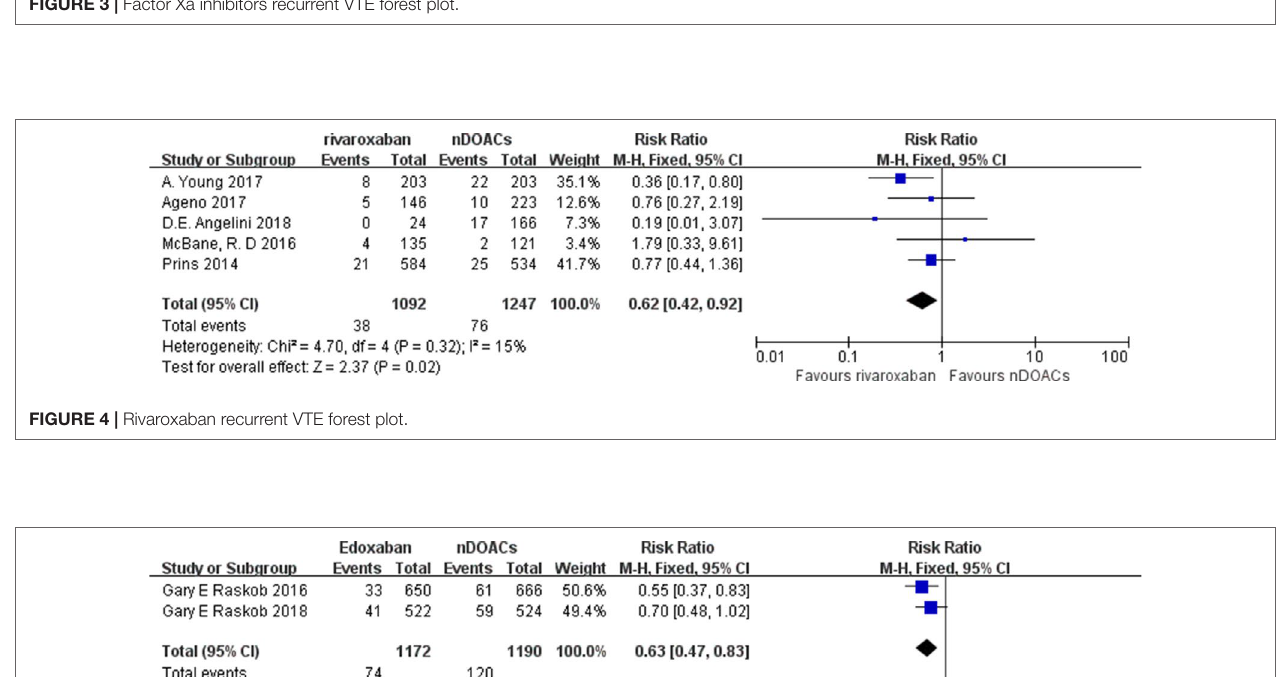
FIGURE 3 | Factor Xa inhibitors recurrent VTE forest plot.